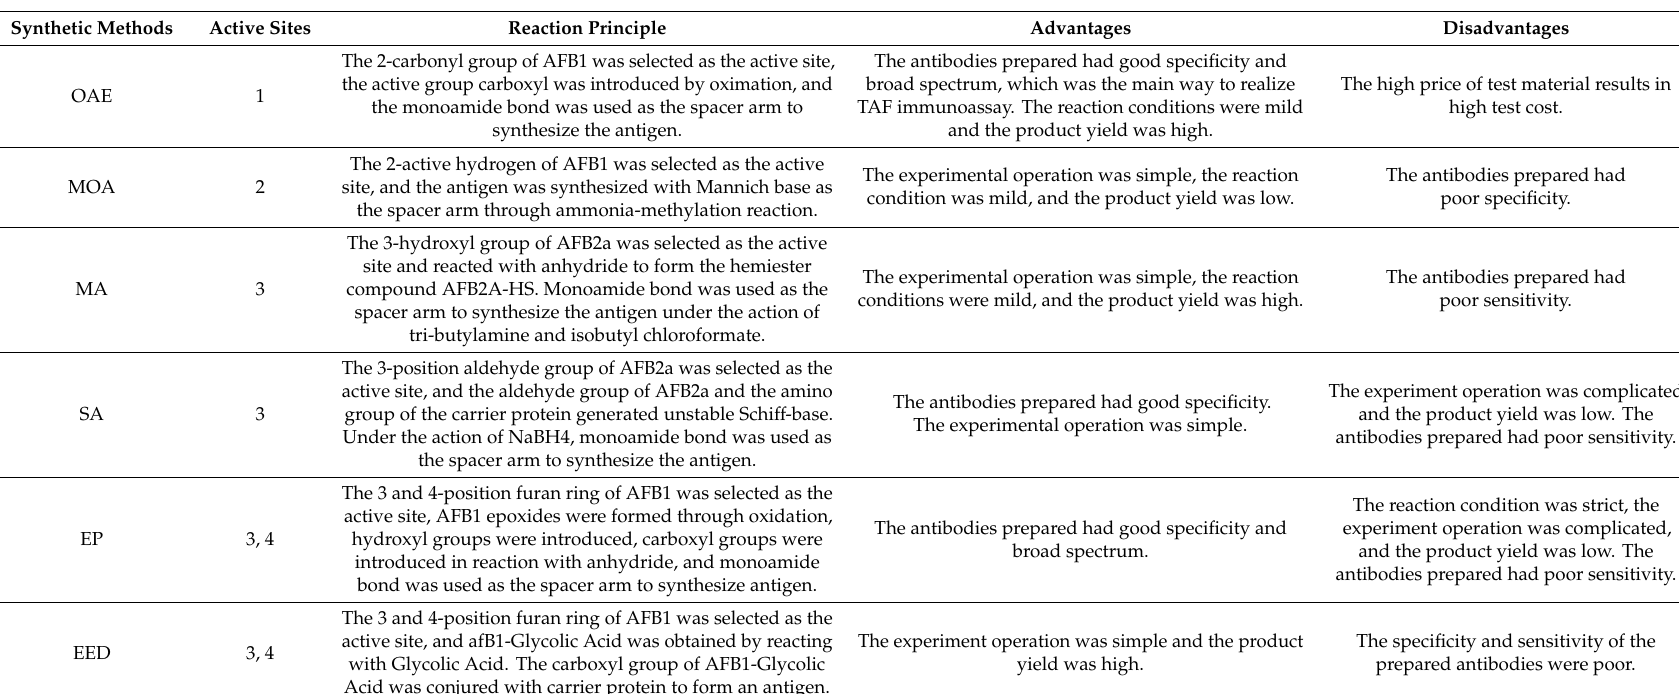
Table 1. Comparison of antigen synthesis methods of B-group